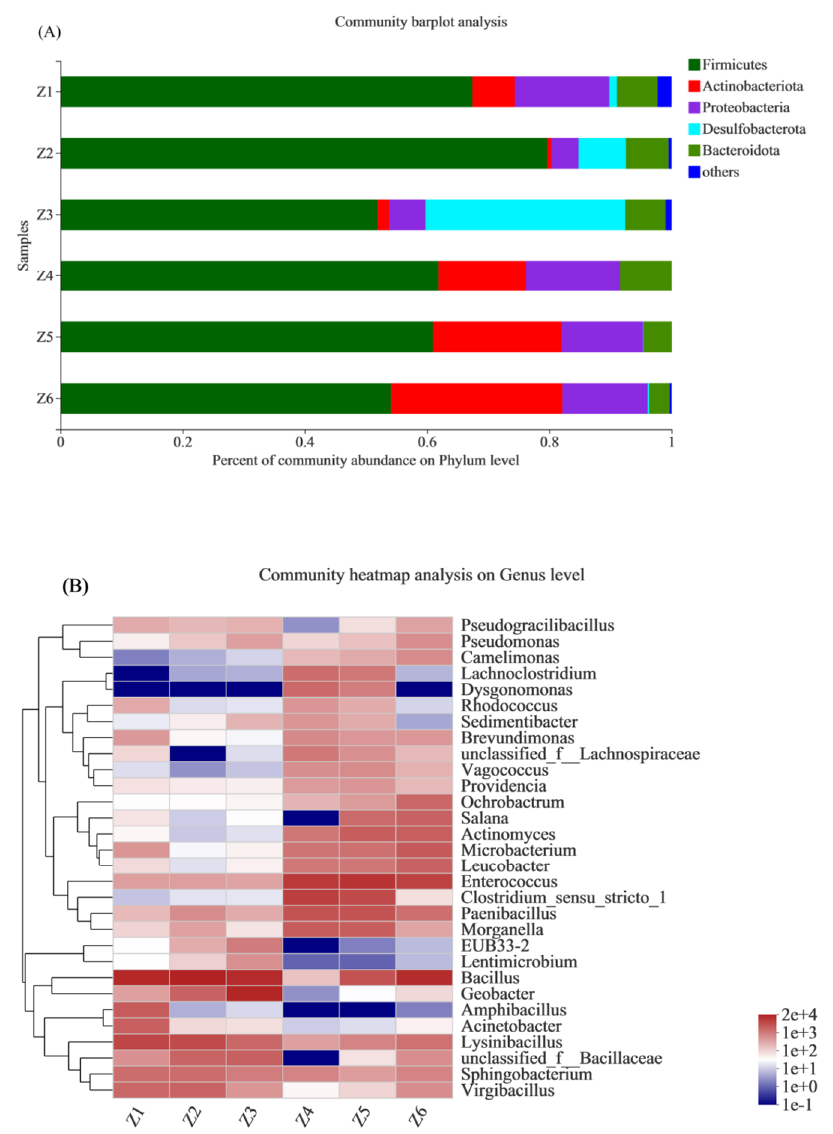
Figure 4. Microbial community at the ( A ) phylum and ( B ) genus levels. Z1, Z2, Z3, Z4, Z5, and Z6 represent the 6 experimental groups of 0, 50, 100, 200, 300, and 400 mg/L mixed flocculant, respec- tively.